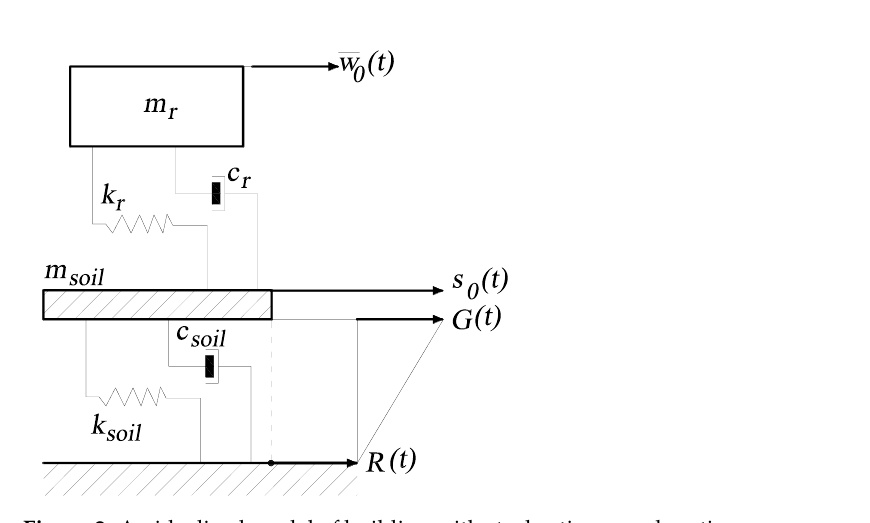
Figure 2. An idealized model of building with stochastic ground